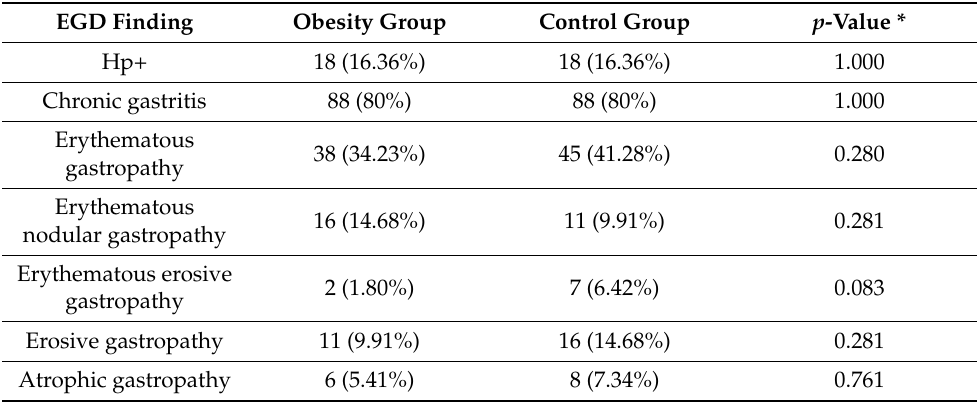
Table 3. Gastric pathologies found using EGD in the study